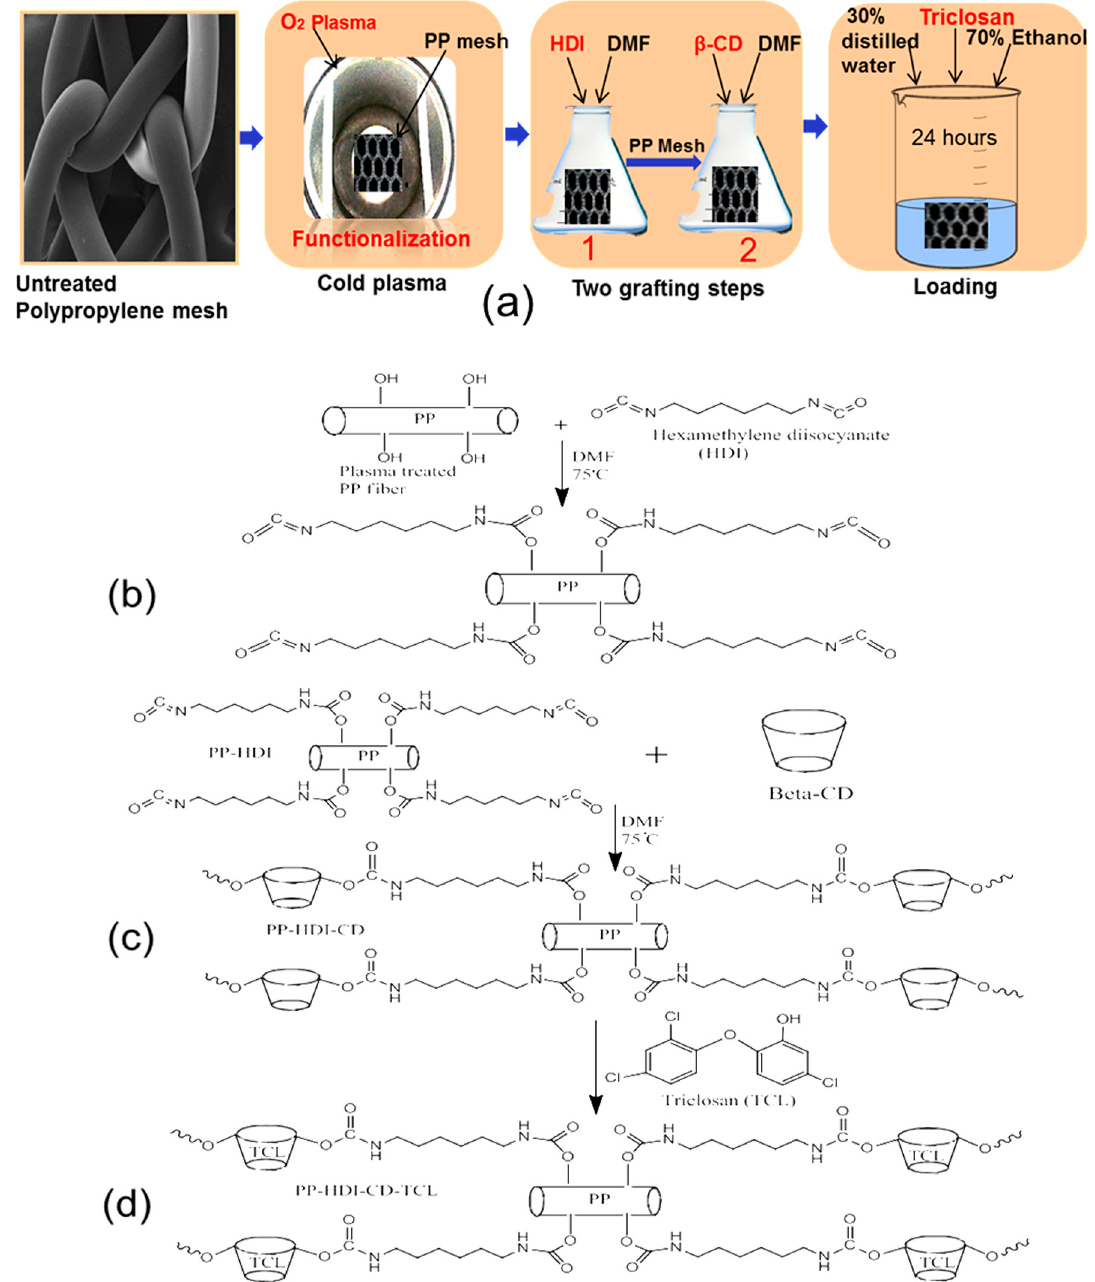
Figure 1. ( a ) Illustrations of experimental design for β -CD grafted antibacterial surgical PP meshes; Schemes ( b ) step-1, PP-HDI grafting; ( c ) step-2, PP-HDI-CD grafting; and ( d ) triclosan loaded meshes.